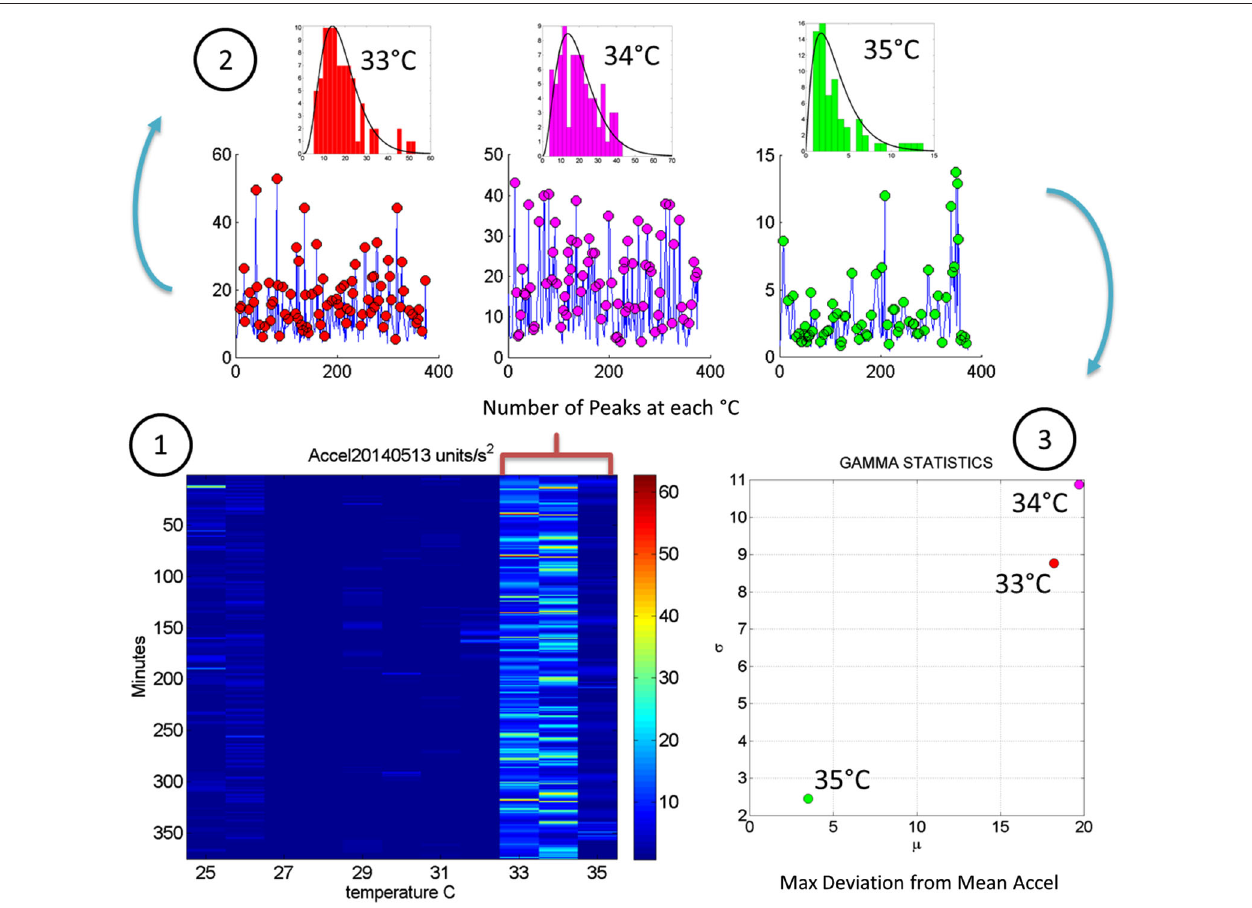
predictable noise-to-signal ratio. The frequency histogram of the peak deviations from the mean is obtained for each ◦ C interval and the best fitting probability distribution function obtained (3). Obtain the empirically estimated Gamma mean and Gamma variance from the experimental data using the estimates of the shape and scale Gamma parameters (see text for